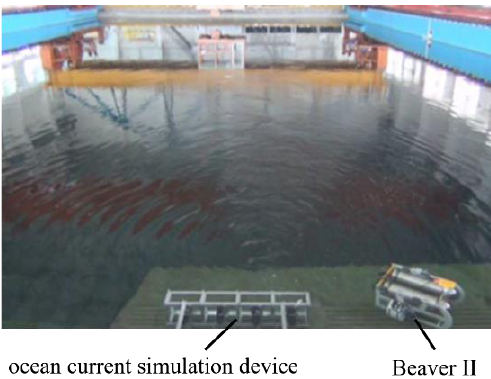
Figure 3. Experimental condition.